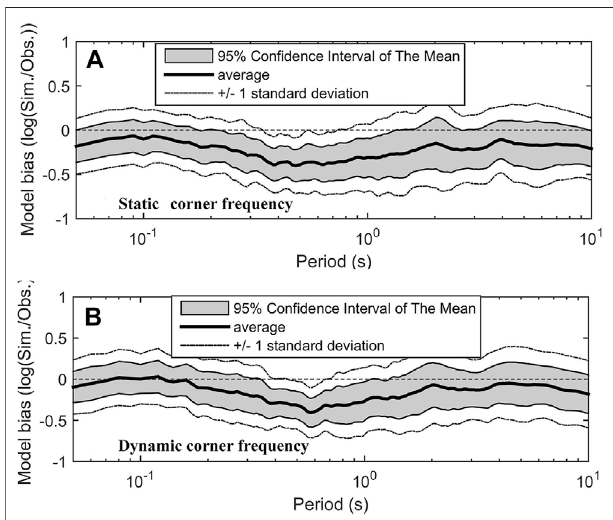
FIGURE 8 | Model bias [log(SA Simulated ) — log(SA Observed )) and standard deviation for the 15 stations in the Northridge earthquake calculated by the static corner frequency and the dynamic corner frequency, respectively; (A) the static corner frequency; (B) the dynamic corner frequency.